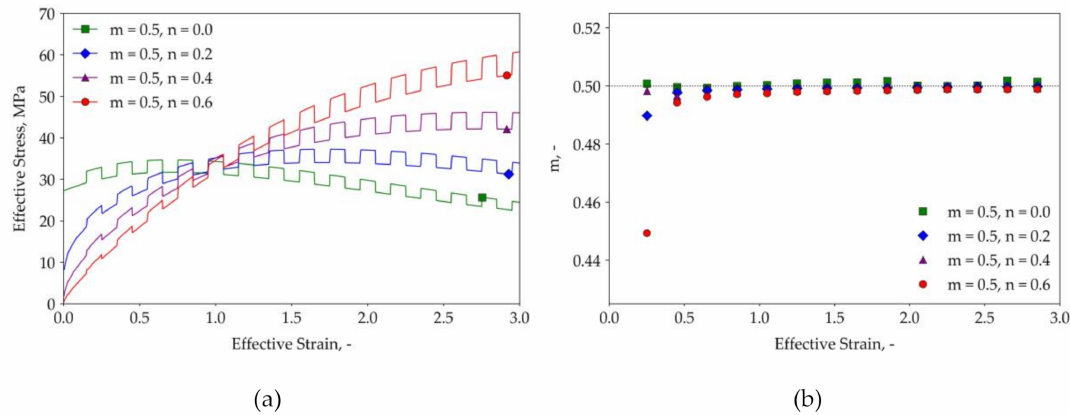
Figure 12. The simulation of the step tests aimed to determine the m value: ( a ) the stress–strain curves corresponding to the step tests for the material with m = 0.5 and di ff erent n values; ( b ) the obtained values of strain-rate sensitivity index ( m ) related to the e ff ective